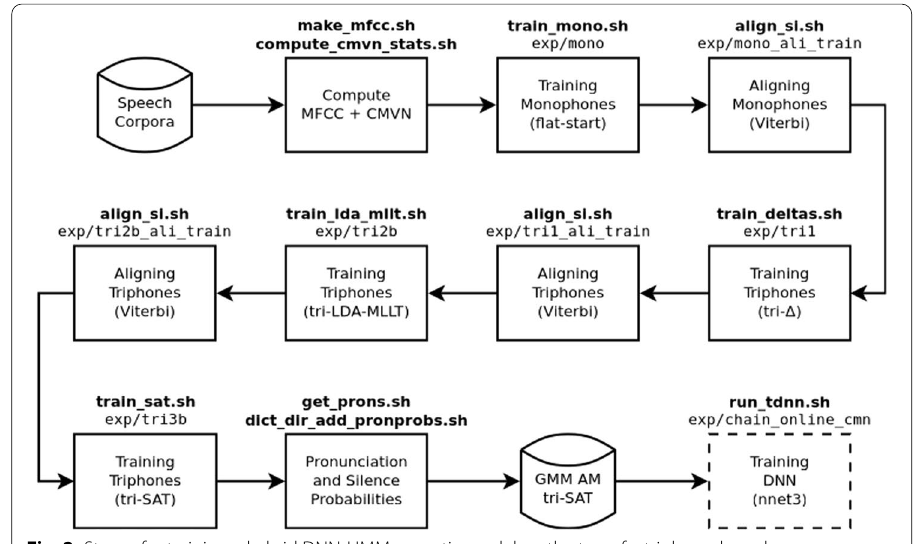
Fig. 2 Stages for training a hybrid DNN-HMM acoustic model on the top of a triphone-based, speaker-adapted GMM one. Lexicon and LM are omitted, but are basic inputs for all training blocks as well as the MFCCs. Scripts are based on Kaldi’s Mini-librispeech recipe, and the DNN in particular was trained following the nnet3 setup. At the top of each block, there is a reference for a script (boldface) and a directory where resources created by that script are usually stored (normal text). More details on the DNN training (dashed block) are depicted in Fig.